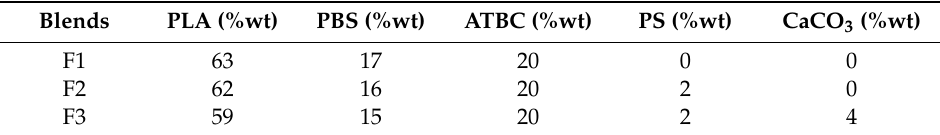
Plasticized poly(lactic acid) (PLA) / poly(butylene succinate) (PBS) blends prepared by